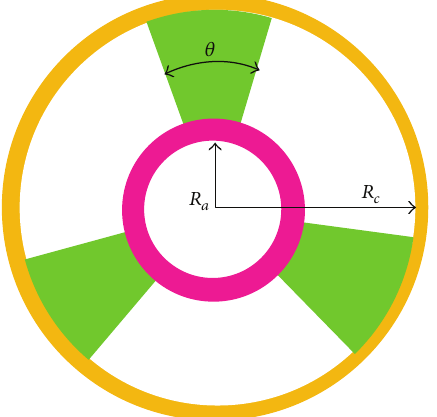
Figure 3: Illustration of the cross section of the helix